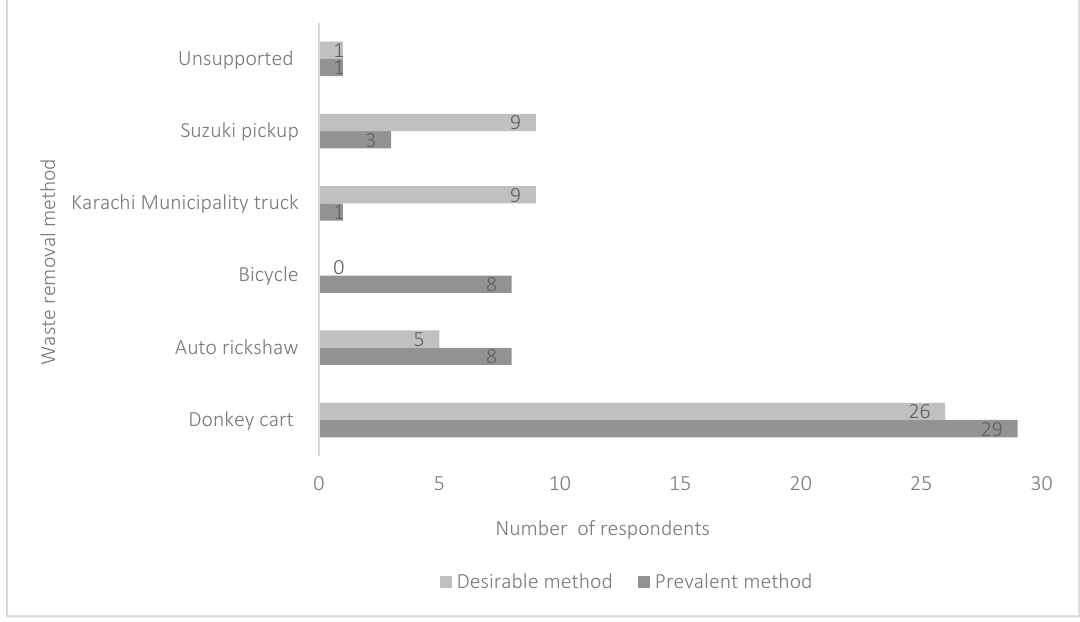
Figure 4. Reported prevalent and desirable waste management systems reported by questionnaire respondents who employ donkey cart owners to remove waste from their property.